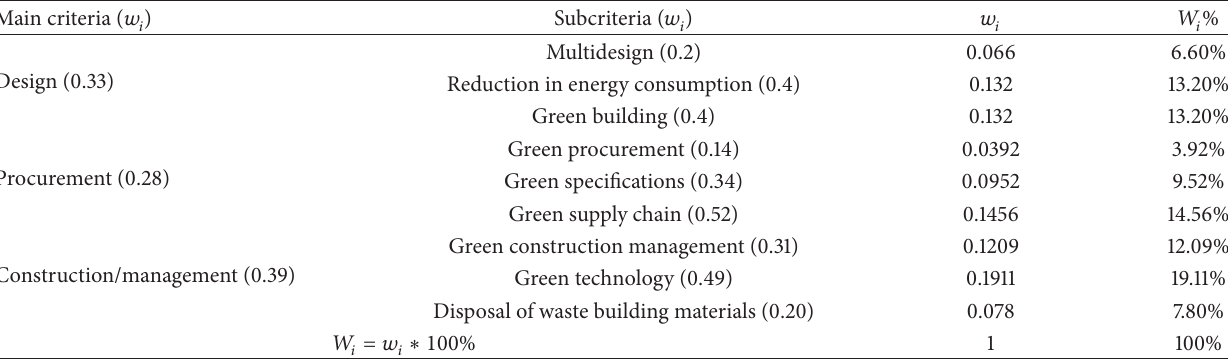
Table 8: Weighting value of each